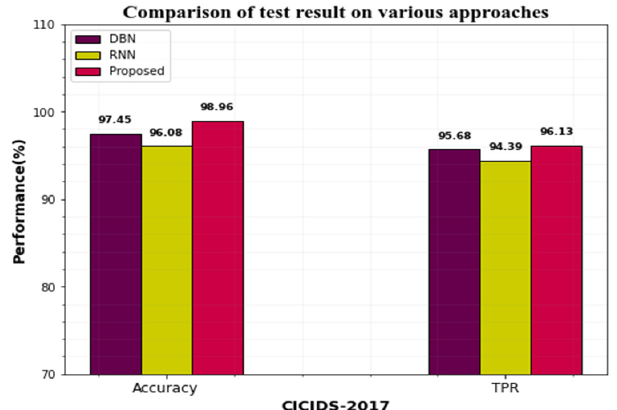
Figure 8. Differentiation performance of the CICIDS dataset proposed approach with existing.